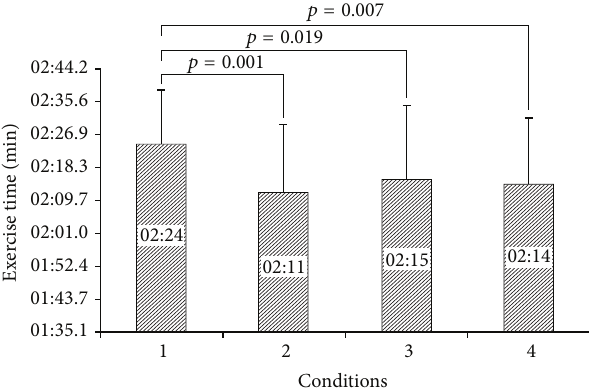
Figure 2: Completion time for a circuit resistance exercise (mean ± SD). 1: WU+RE without M, 2: WU+RE with M, 3: WU with M+RE without M, and 4: WU without M+RE with